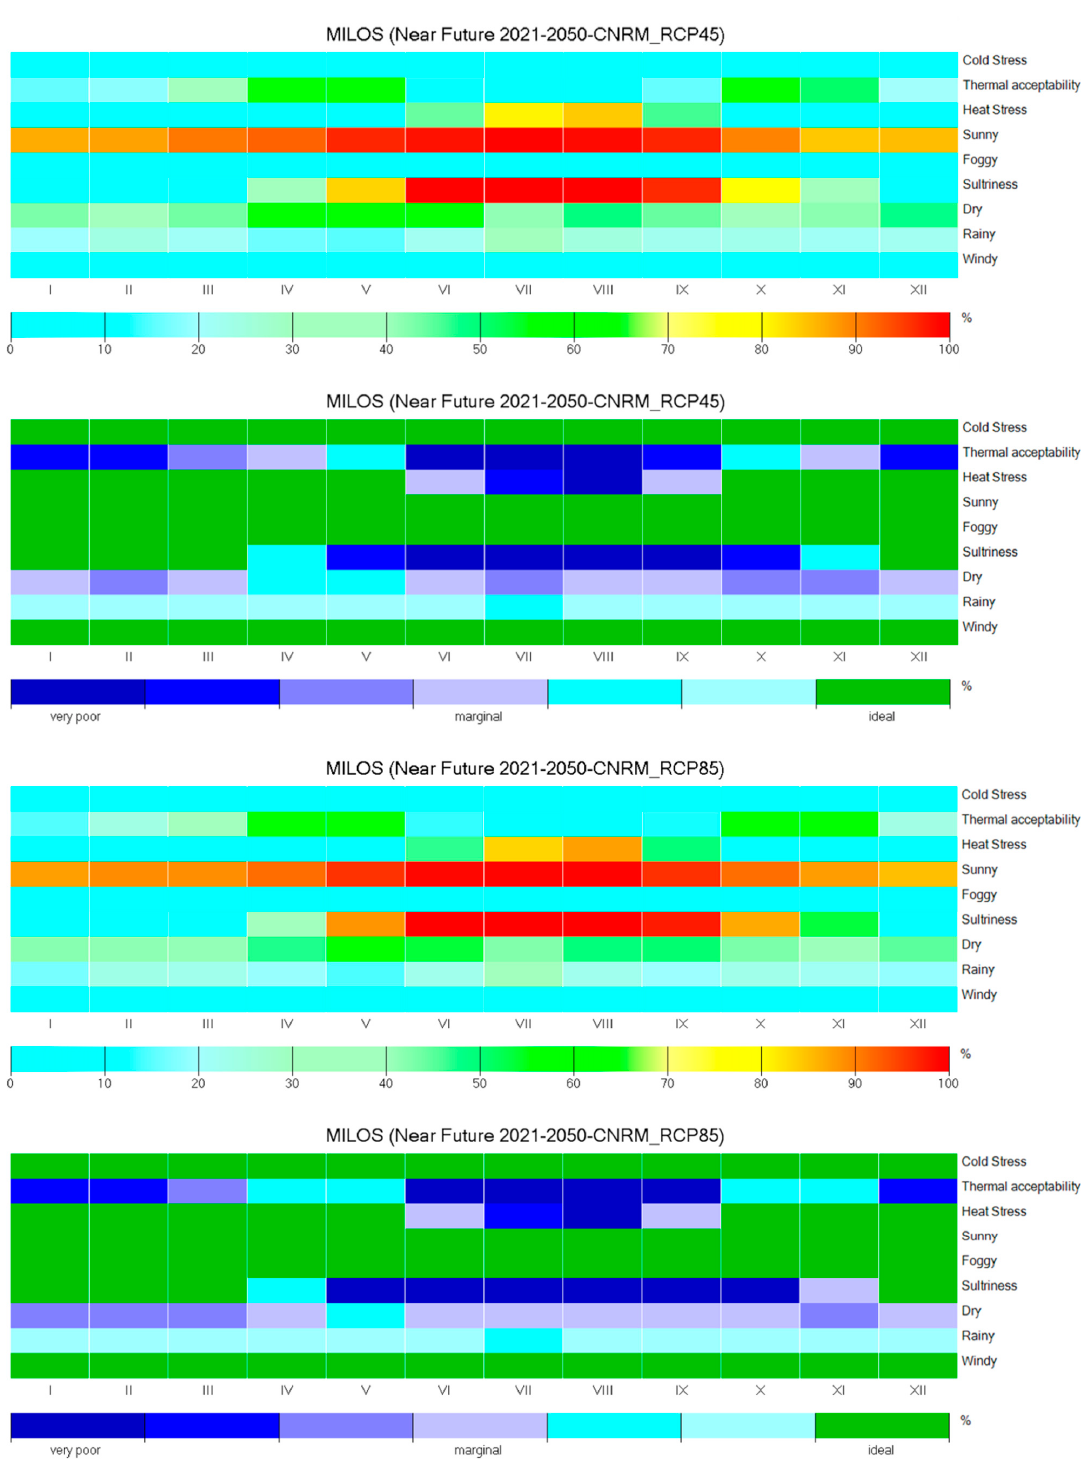
Figure 6. Climate-Tourism-Information-Scheme (CTIS), expressed by probabilities (%) and by suitability of climatic factors for Milos island for the near future 2021–2050, based on the CNRM regional climate model for two Representative Concentration Pathways, RCP4.5 (upper graphs) and RCP8.5 (lower graphs).